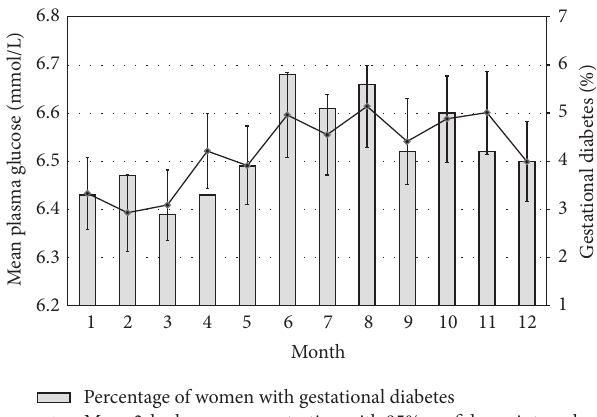
Figure 1: Monthly mean 2-h glucose levels and the monthly percentage of women with gestational diabetes